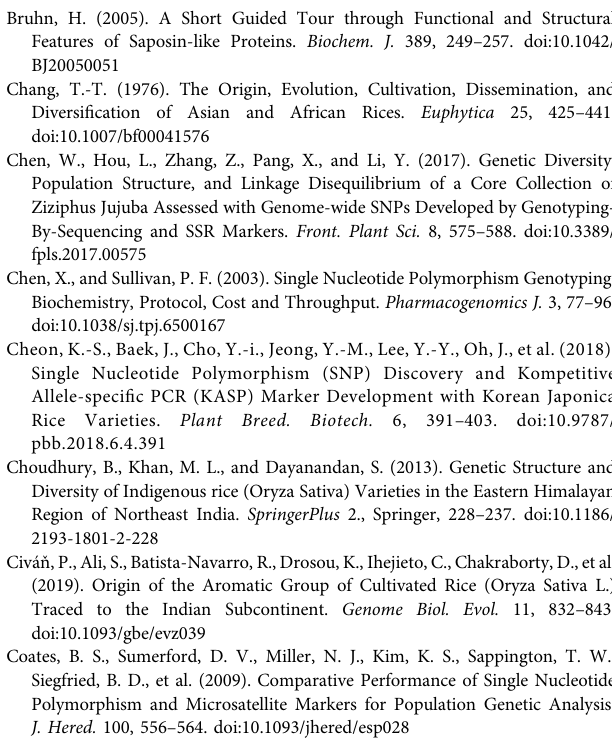
Supplementary Figure S7 | Venn diagram showing co-linearity between all three groups of neighbor joining tree and population 3 of population structure of total east Supplementary Figure S8 | Venn diagram showing co- linearity between all three groups of neighbor joining tree and population 4 of population structure of total east Supplementary Figure S9 | Hierarchical population structure analysis of subpopulation of population 1 total east coast rice collection Supplementary Figure S10 | Bar plot of population 1 highlighting the sub populations in east coast rice collection Supplementary Figure S11 | Hierarchical population structure analysis of subpopulation of population 2 total east coast rice collection Supplementary Figure 12 | Bar plot of population 2 highlighting the sub populations in east coast rice collection Supplementary Figure S13 | Hierarchical population structure analysis of subpopulation of population 3 total east coast rice collection Supplementary Figure S14 | Bar plot of population 3 highlighting the sub populations in east coast rice collection Supplementary Figure S15 | Hierarchical population structure analysis of subpopulation of population 4 total east coast rice collection Supplementary Figure S16 | Bar plot of population 4 highlighting the sub populations in east coast rice collection Supplementary Figure S17 | Estimation of population using LnP(D) derived Δ k for k from 2 to10 of Andhra Pradesh rice collection Supplementary Figure S18 | Bar plot of population structure of Andhra Pradesh rice collection Supplementary Figure S19 | Estimation of population using LnP(D) derived Δ k for k from 2 to10 of Orissa rice collection SupplementaryFigureS20| BarplotofpopulationstructureofOrissaricecollection